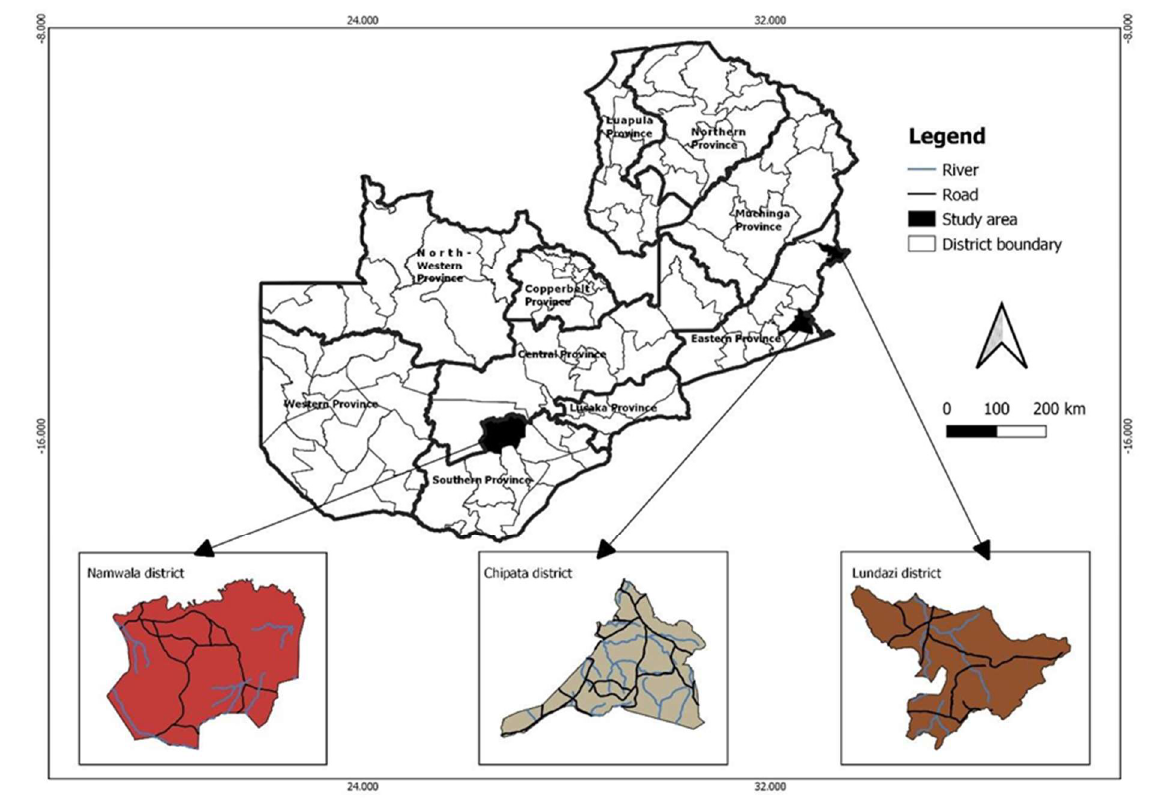
Figure 1. Map showing the study area of Namwala, Chipata and Lundazi Districts. Adopted from [30].